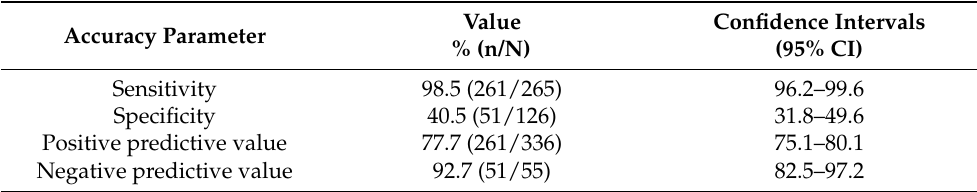
Table 2. Diagnostic accuracy of the Pf HRP2-based RDT performed at health facilities compared with